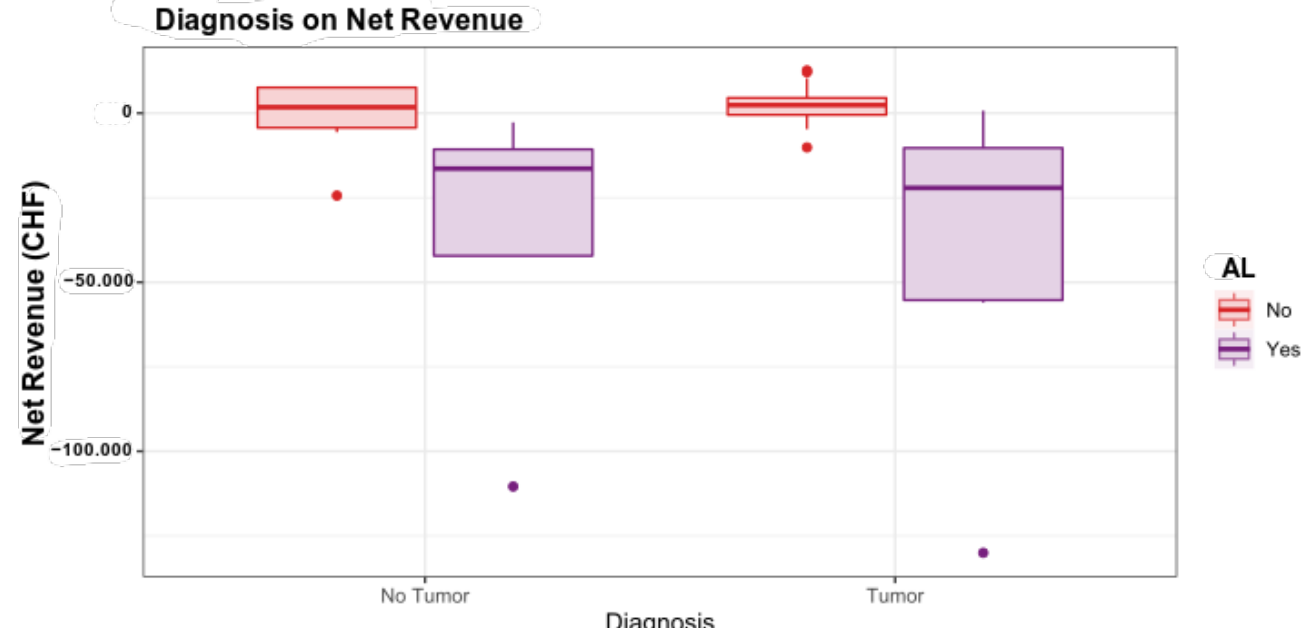
Figure 2. The influence of the intensive care unit stay is significant. In patients without AL, the duration of intensive care stay only has a minor influence on the net revenue. Whereas in patients with AL, losses are expected from the first day of the intensive care unit stay.